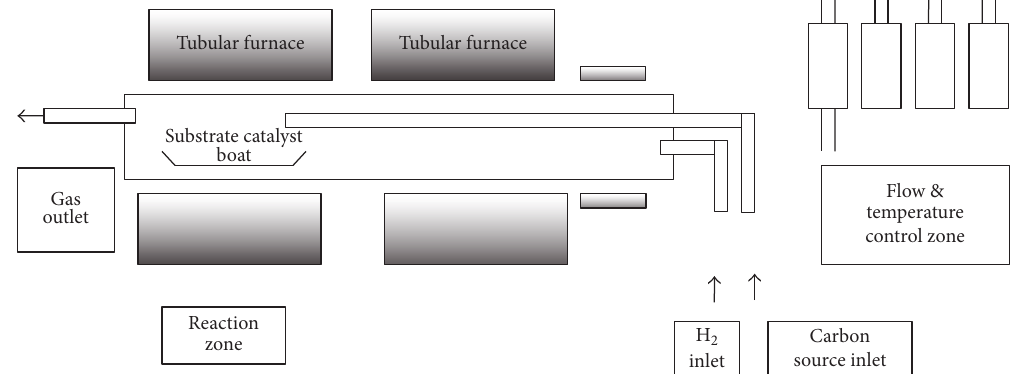
Figure 1: Schematic diagram of multipurpose triple stage CVD system.